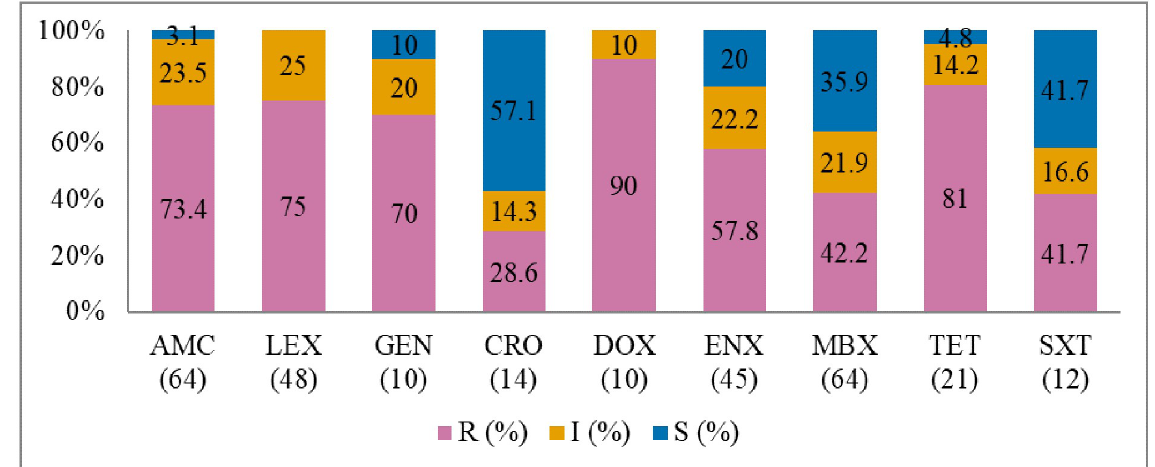
Fig 3. Antibiotic susceptibility pattern from Escherichia coli isolates from diseased cats (January 2015–December 2017). R–resistance; I- intermediate; S–susceptible; AMC–amoxicillin/clavulanic acid; LEX–cephalexin; GEN–gentamicin; CRO–ceftriaxone; DOX–doxycycline; ENX–enrofloxacin; MBX–marbofloxacin; TET–tetracycline; SXT–trimethoprim-sulfamethoxazole. Numbers inside brackets ‘()’ indicate the total number of tested isolates for each antibiotic.